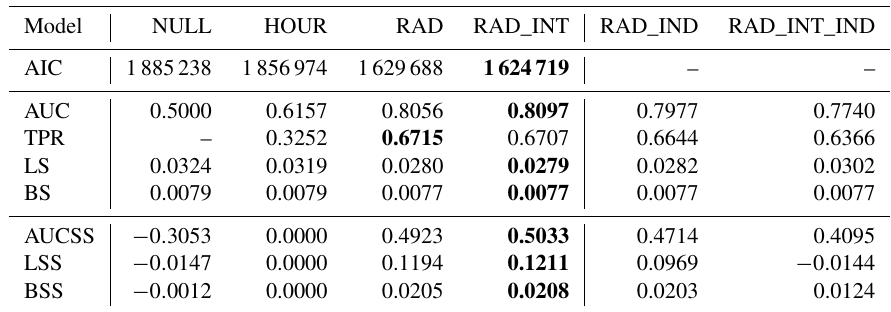
Table 3. Verification measures for models using radar and reanalysis data. Akaike information criterion (AIC), area under receiver operating characteristic curve (AUC), true positive rate (TPR), logarithmic score (LS) and Brier score (BS). Scores computed in a yearly cross- validation approach for each administrative district are shown as an average of all districts. Skill scores of AUC, LS and BS are computed with the model HOUR as reference (see Table 2). The best value of each score is written in bold. Model NULL HOUR RAD RAD_INT RAD_IND RAD_INT_IND AIC –